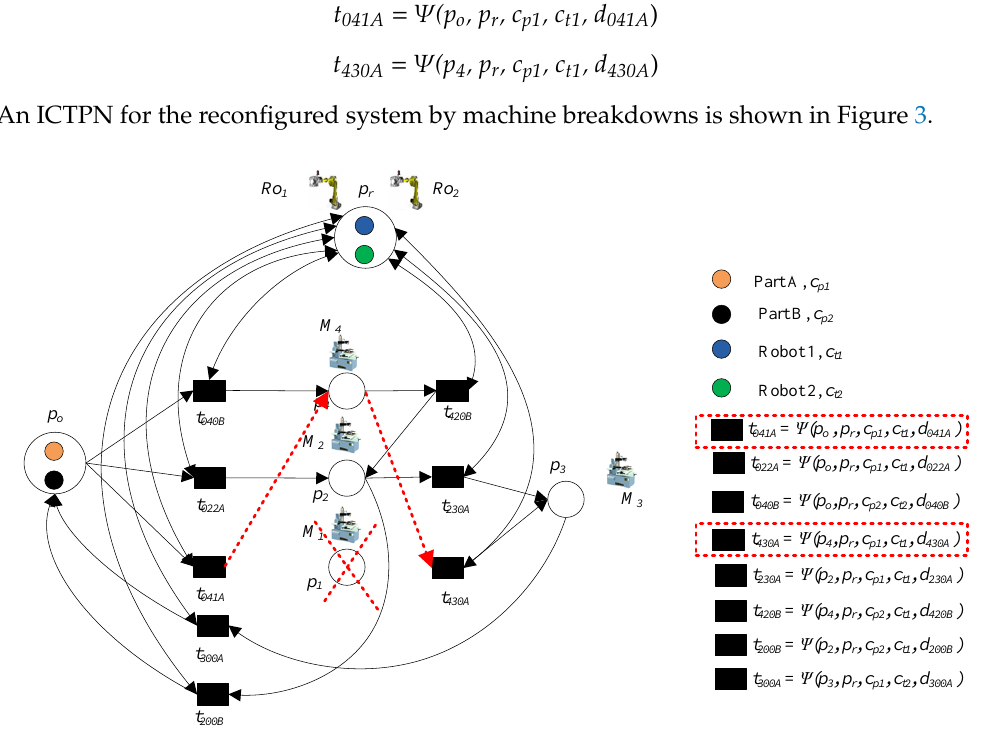
Figure 3. An ICTPN for the reconfigured system by machine breakdowns.